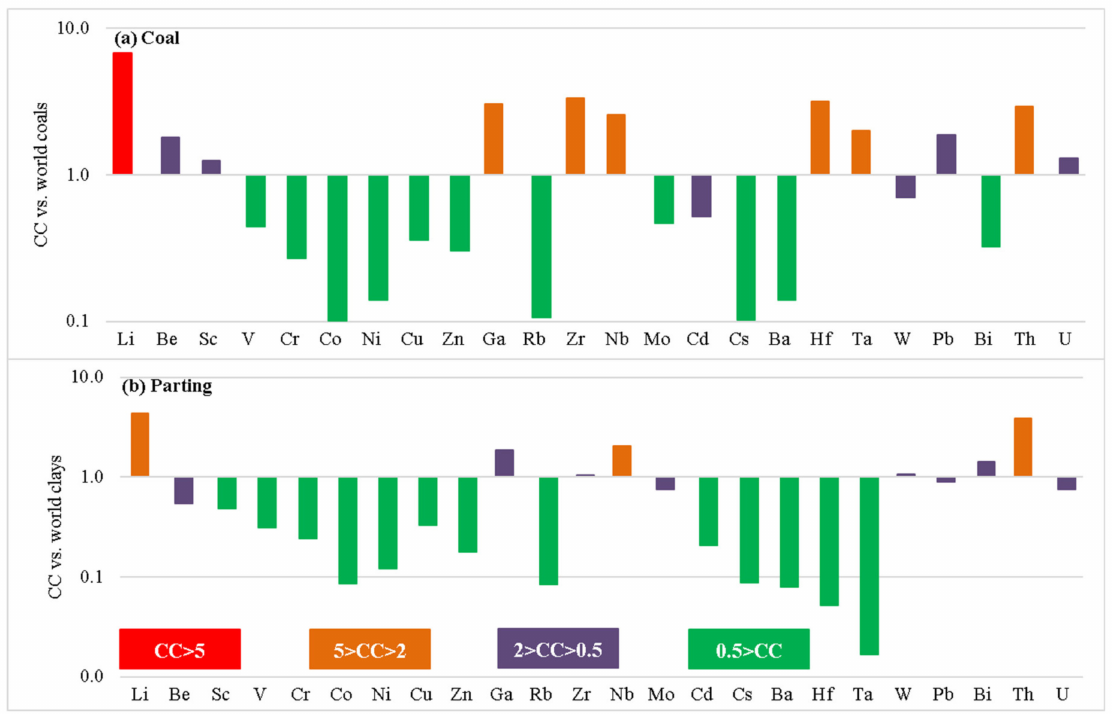
Figure 5. Concentration coe ffi cients of trace elements in coals ( a ) and partings ( b ) from the Wujiawan mine at Datong coalfield, normalized by the average concentrations of trace elements in world hard coals and world clays,